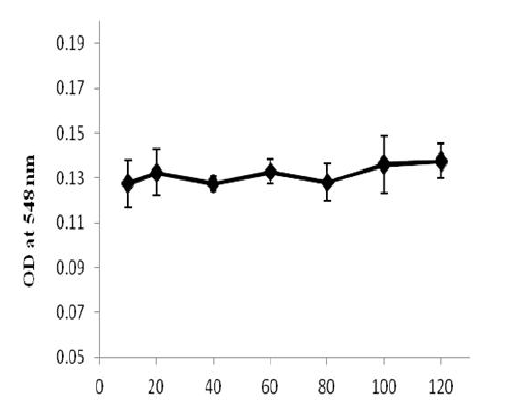
Time Fig. 2. Examination of the enzymatic activity of AlgL at various periods of time of incubation. Reaction mixture containing a crude enzyme preparation from P.aeruginosa strain 214 and sodium alginate as substrate was incubated at 37°C and examined at different periods of time. Then the enzyme activity was determined.